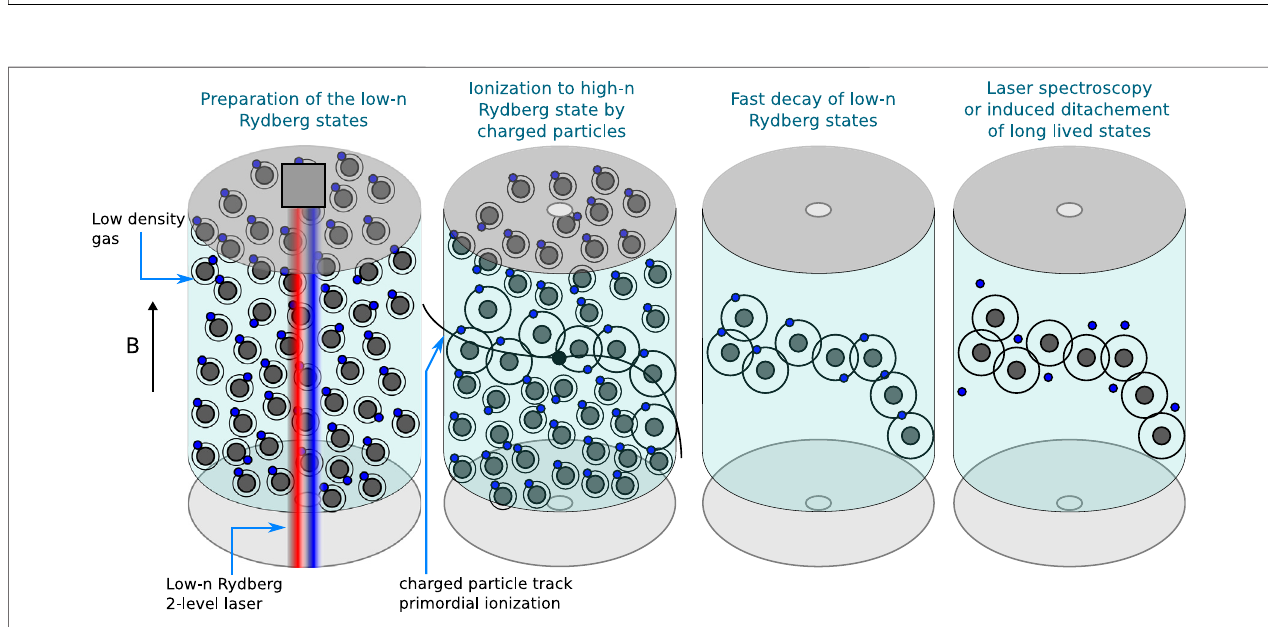
FIGURE 6 | Scheme of a tracking chamber using Rydberg atoms as sensing medium. The measurement is performed in four steps. First, via two-level laser excitation,theatomsintheprimaryionizationregionarebroughttoalow-nRydbergstatesynchronouslywiththecollisiontime.Inthesecondstep,thechargedparticles produced in thereaction ionizeor excitethe Rydberg atomsalongtheir fl ightpath. Afterthat, theshort lived states decay back totheground stateand thehighly excited Rydberg states can be read out using opto-electronic means, such as electromagnetic induced transparency. Alternatively, the electrons can be photo-detached and detected as an effective locally increased ionization cloud using standard